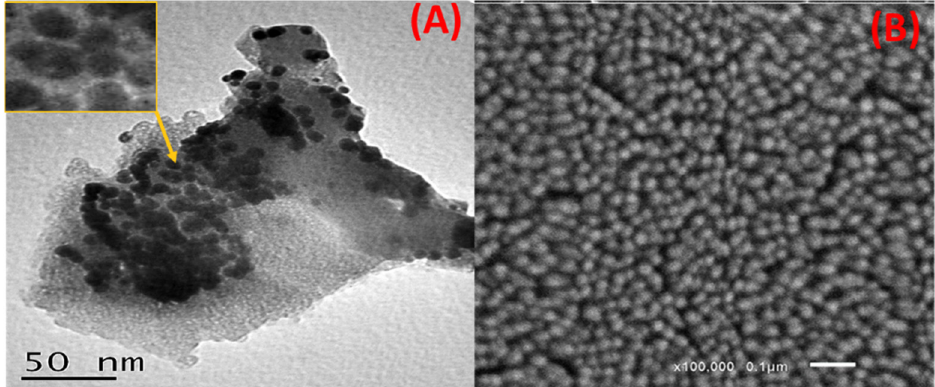
Figure 4. (A) HRTEM and ( B ) SEM images of the capped Ag NPs.